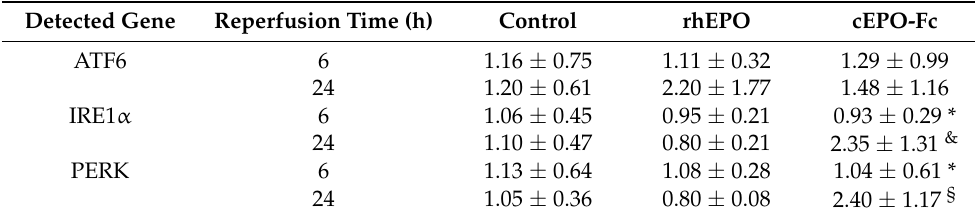
Table 2. RT-qPCR measurements of ATF6, IRE1 α , and PERK in the spinal cord of the animals of the control, recombinant human erythropoietin (rhEPO), and carbamylated erythropoietin FC fusion protein (cEPO-Fc) group after 6 and 24 h of reperfusion. Detected Gene Reperfusion Time (h) Control rhEPO cEPO-Fc ATF6 6 1.16 ± 0.75 1.11 ± 0.32 1.29 ± 0.99 24 1.20 ± 0.61 2.20 ± 1.77 1.48 ± 1.16 IRE1 α 6 1.06 ± 0.45 0.95 ± 0.21 0.93 ± 0.29 * 24 1.10 ± 0.47 0.80 ± 0.21 2.35 ± 1.31 & PERK 6 1.13 ± 0.64 1.08 ± 0.28 1.04 ± 0.61 * 24 1.05 ± 0.36 0.80 ± 0.08 2.40 ± 1.17